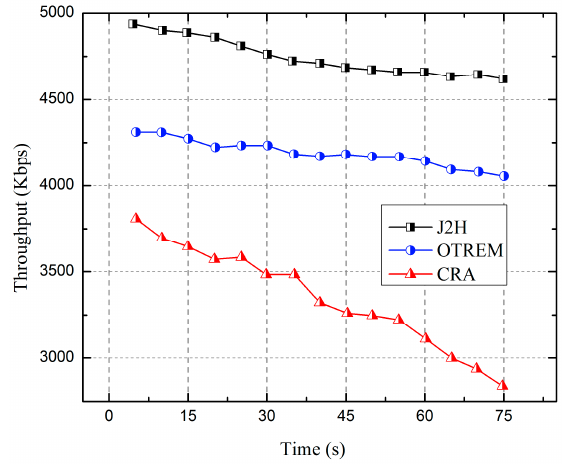
Figure 10. Analysis of throughput when time changes.